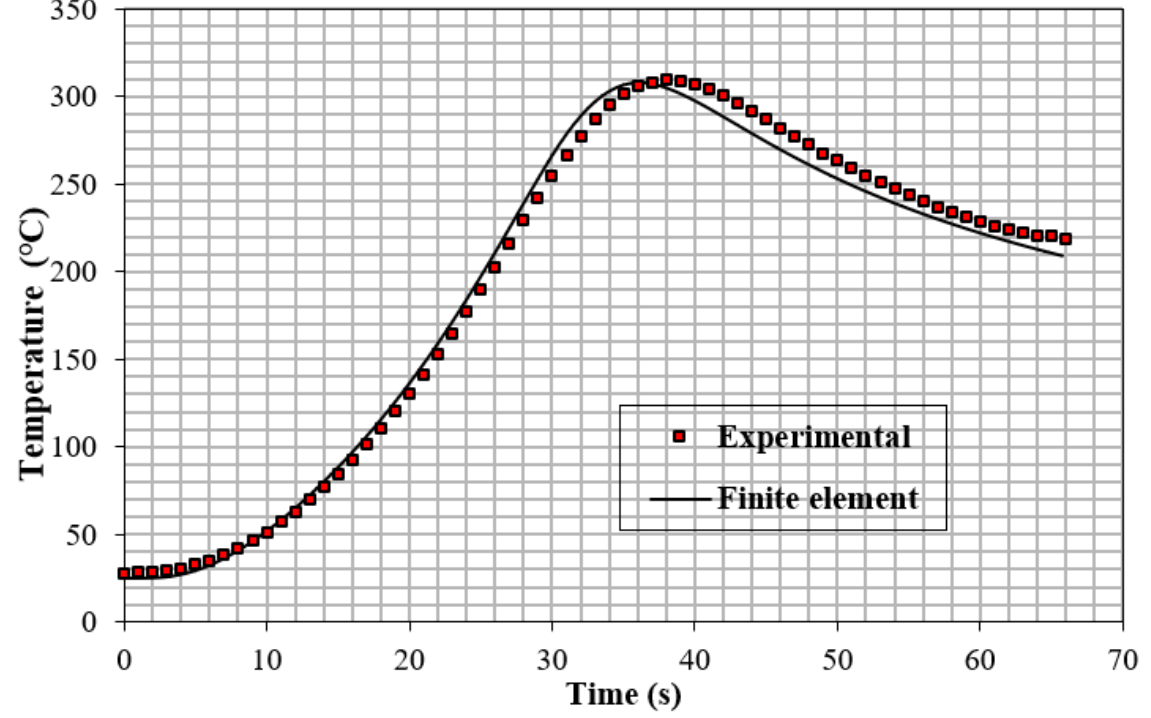
Figure 5. Comparison between numerical and experimental results.